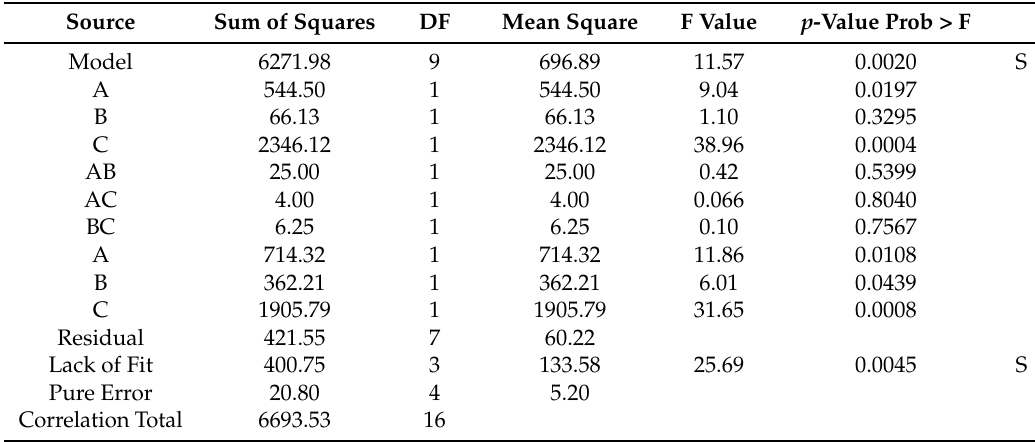
Table 4. Quadratic model by ANOVA for response surface a .